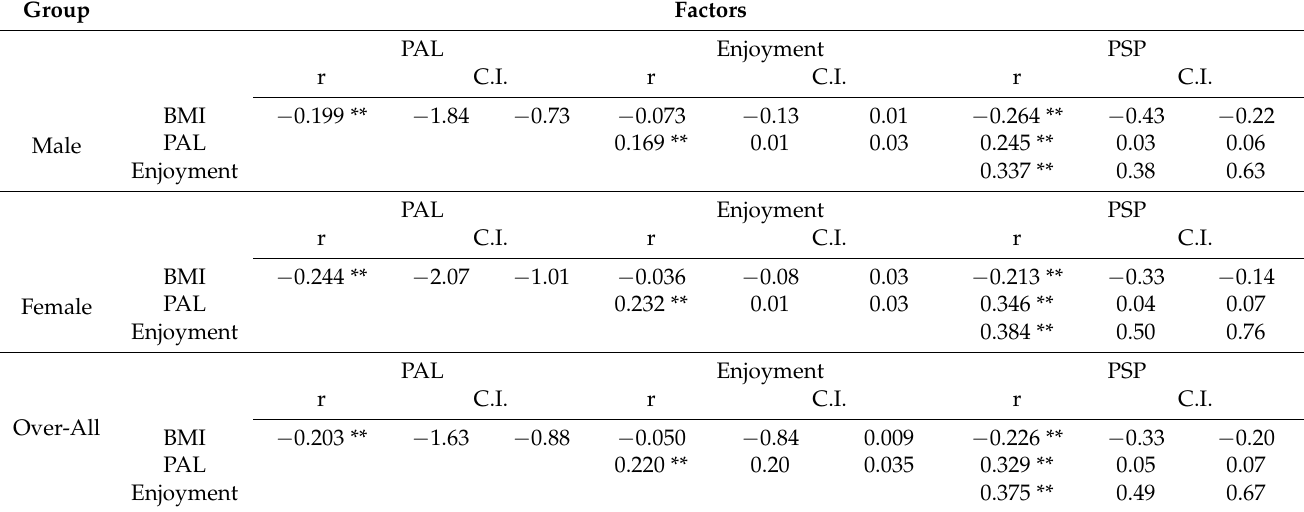
Table 3. Pearson’s correlation coefficients among variables. ** = p <